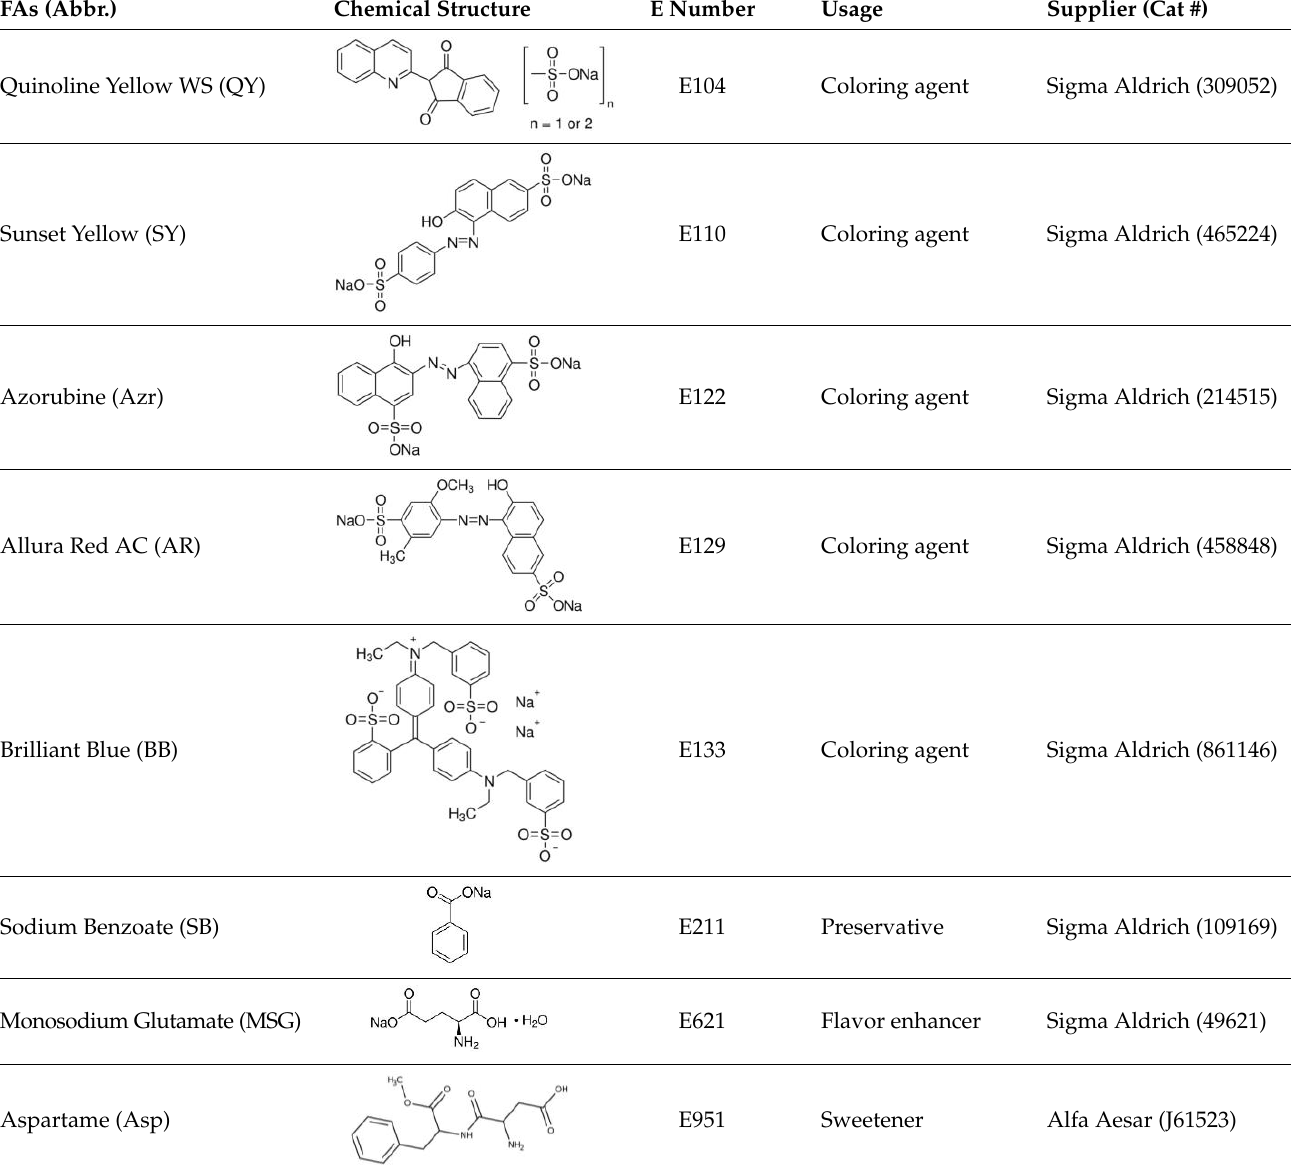
Table 1. List of tested food additives in this study. FAs (Abbr.)